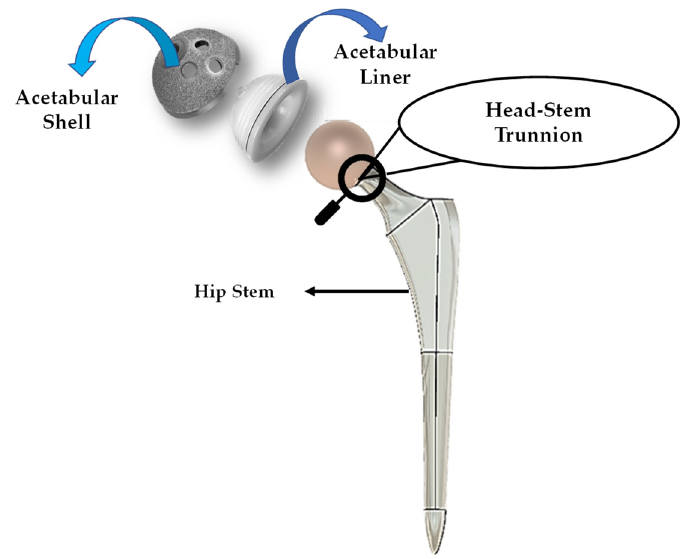
Figure 1. General view of a hip implant with components.